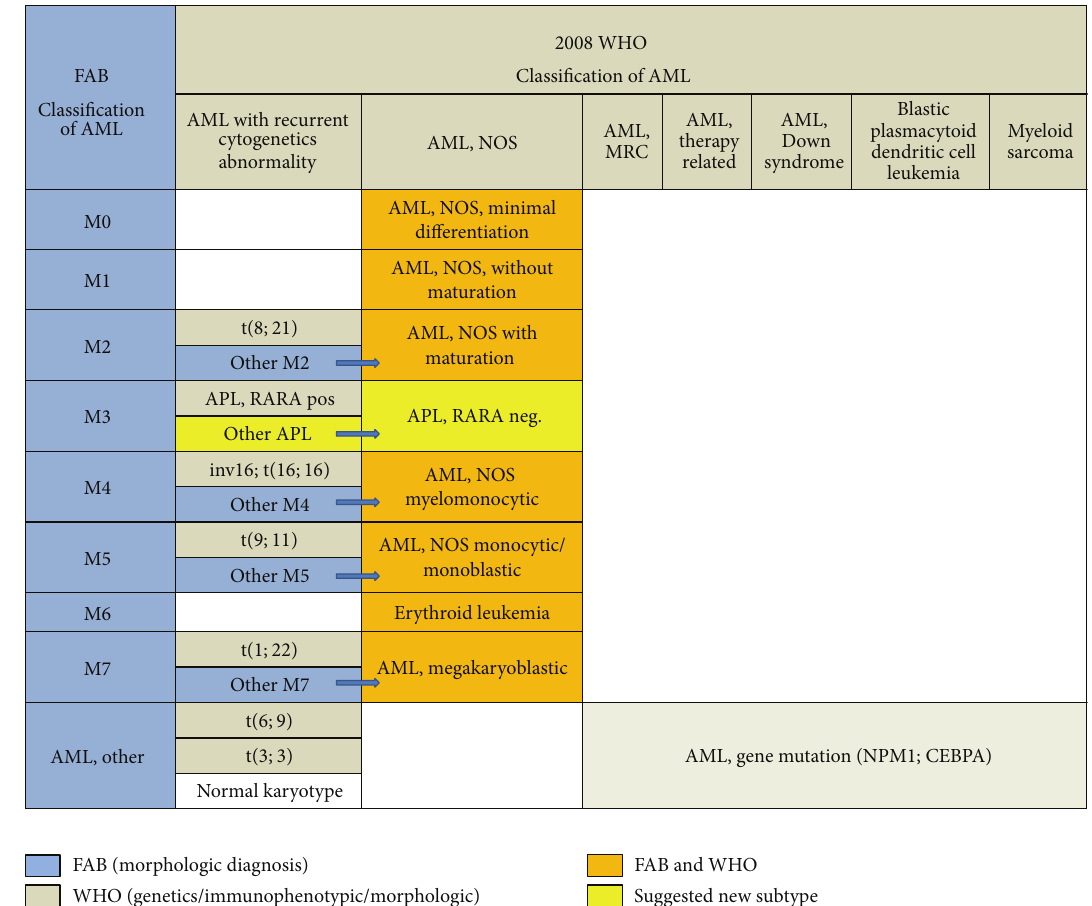
Figure 4: An approximate correlation between FAB and WHO 2008 classifications of AML subtypes, including suggested new subtypes “APL, NOS, and RARA negative.” FAB, French-American-British; WHO, World Health Organization; AML, acute myeloid leukemia; NOS, not otherwise specified; APL, acute promyelocytic leukemia; RARA, retinoic acid receptor alpha; MRC, myelodysplasia related changes.